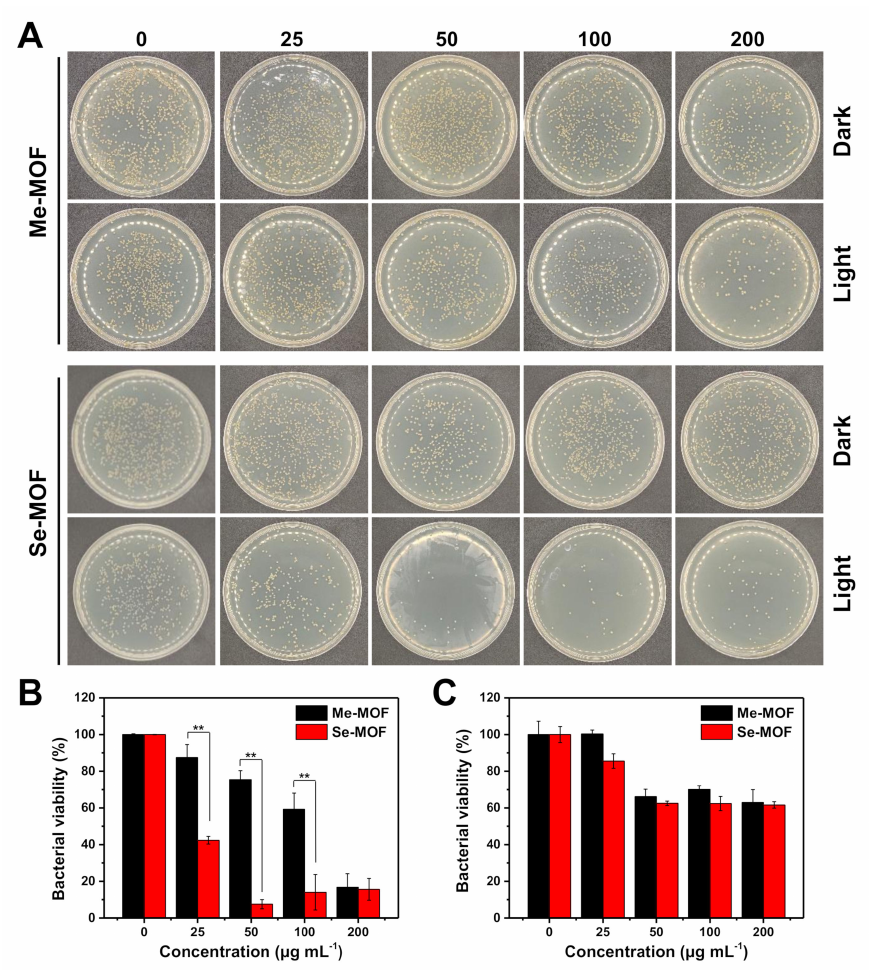
Figure 4. ( A ) Representative photographs of S. aureus colonies in LB agar plates after being incubated with different concentrations of Me-MOF or Se-MOF, followed by irradiation three times with a LED light (450 nm, 3 mW cm − 2 ) for 20 min or incubation in the dark. ( B , C ) Percentage viability of bacteria S. aureus after different treatments, followed by light irradiation ( B ) or incubation in the dark ( C ). Data are presented as mean ± standard deviation ( n = 3; ** p < 0.01).